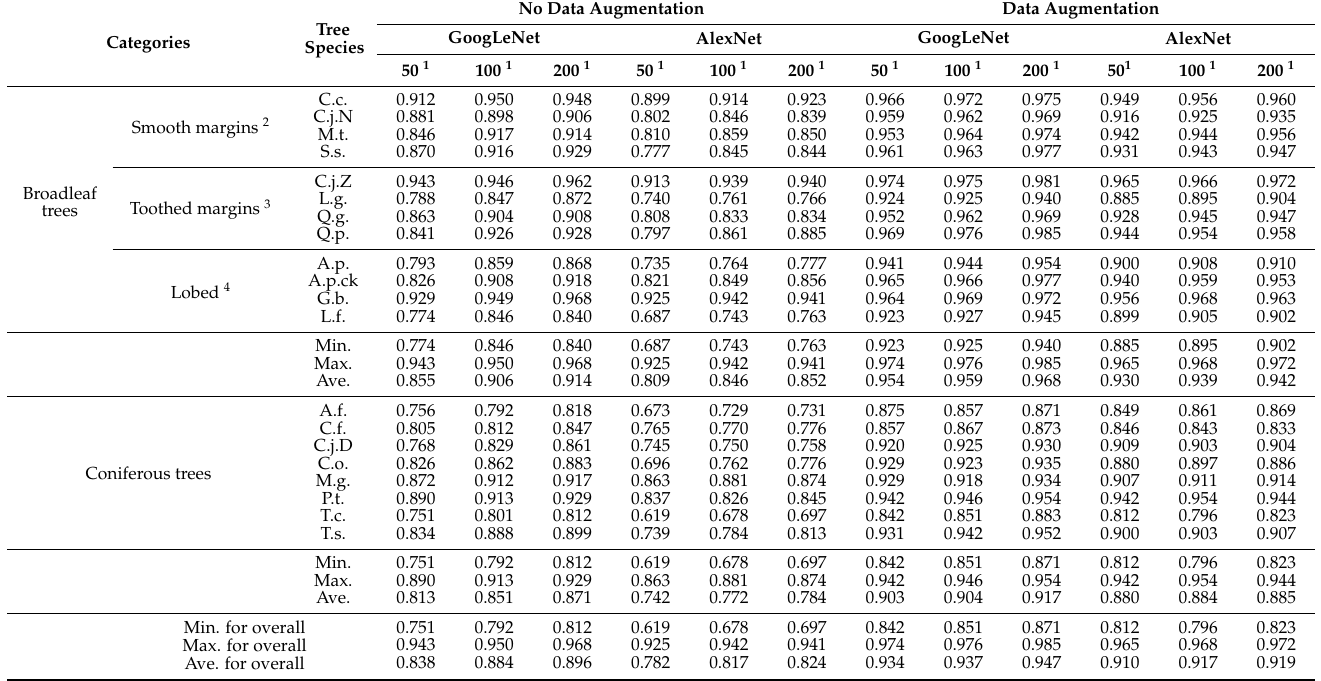
Table 1. Classification accuracy of tree species identification for test data when simultaneously classifying broadleaf and coniferous